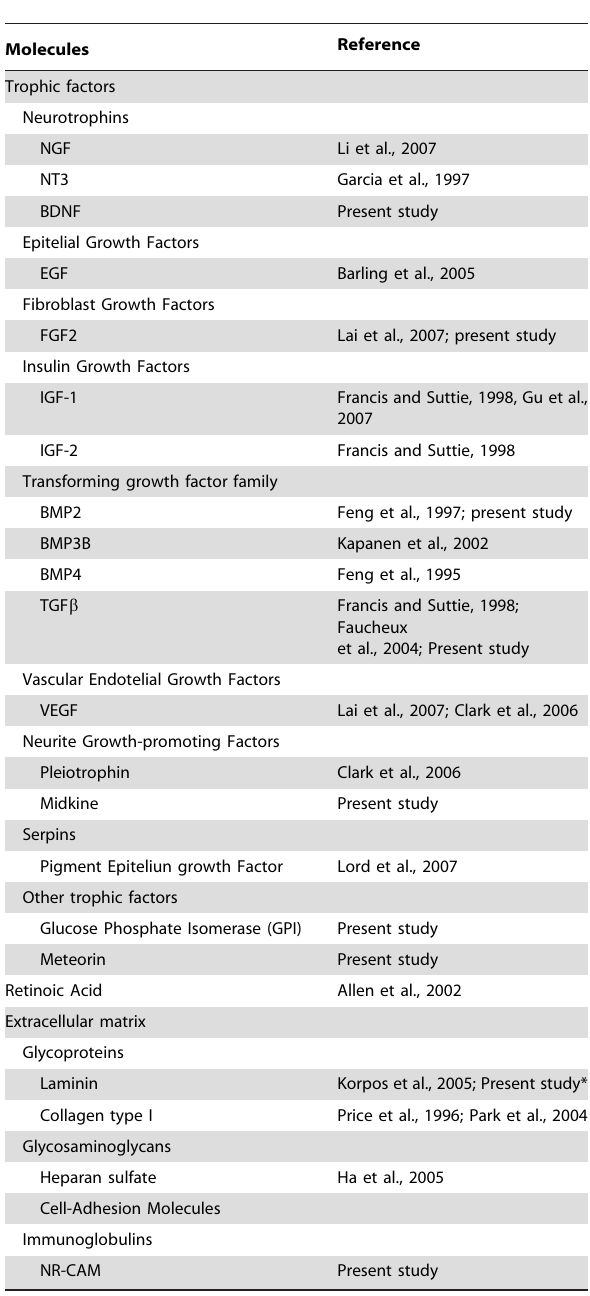
Table 6. Axon growth promoters identified in the regenerating